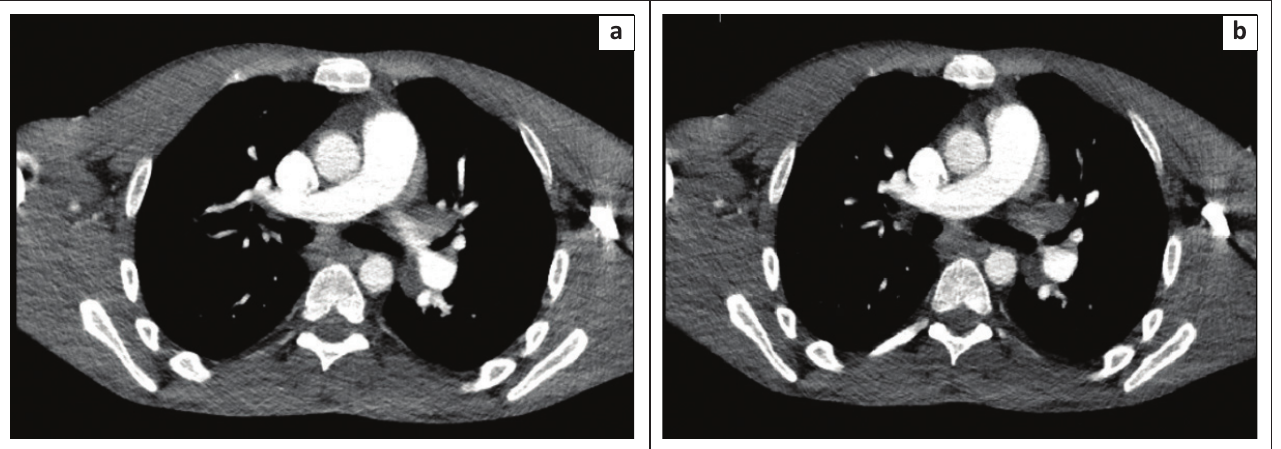
FIGURE 2: Axial slices from portal venous phase contrast enhanced CT thorax, abdomen and pelvis performed at initial presentation, which demonstrates mediastinal (a) and hilar (b) lymph node enlargement. These nodes were later not found to be FDG-avid on FDG-PET-CT.